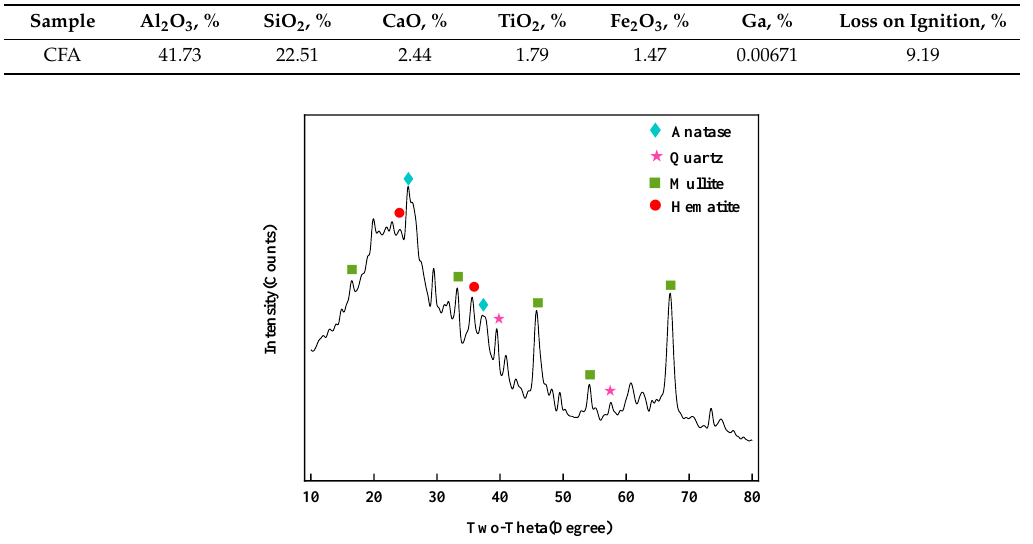
Figure 1. XRD pattern of the original CFA sample.